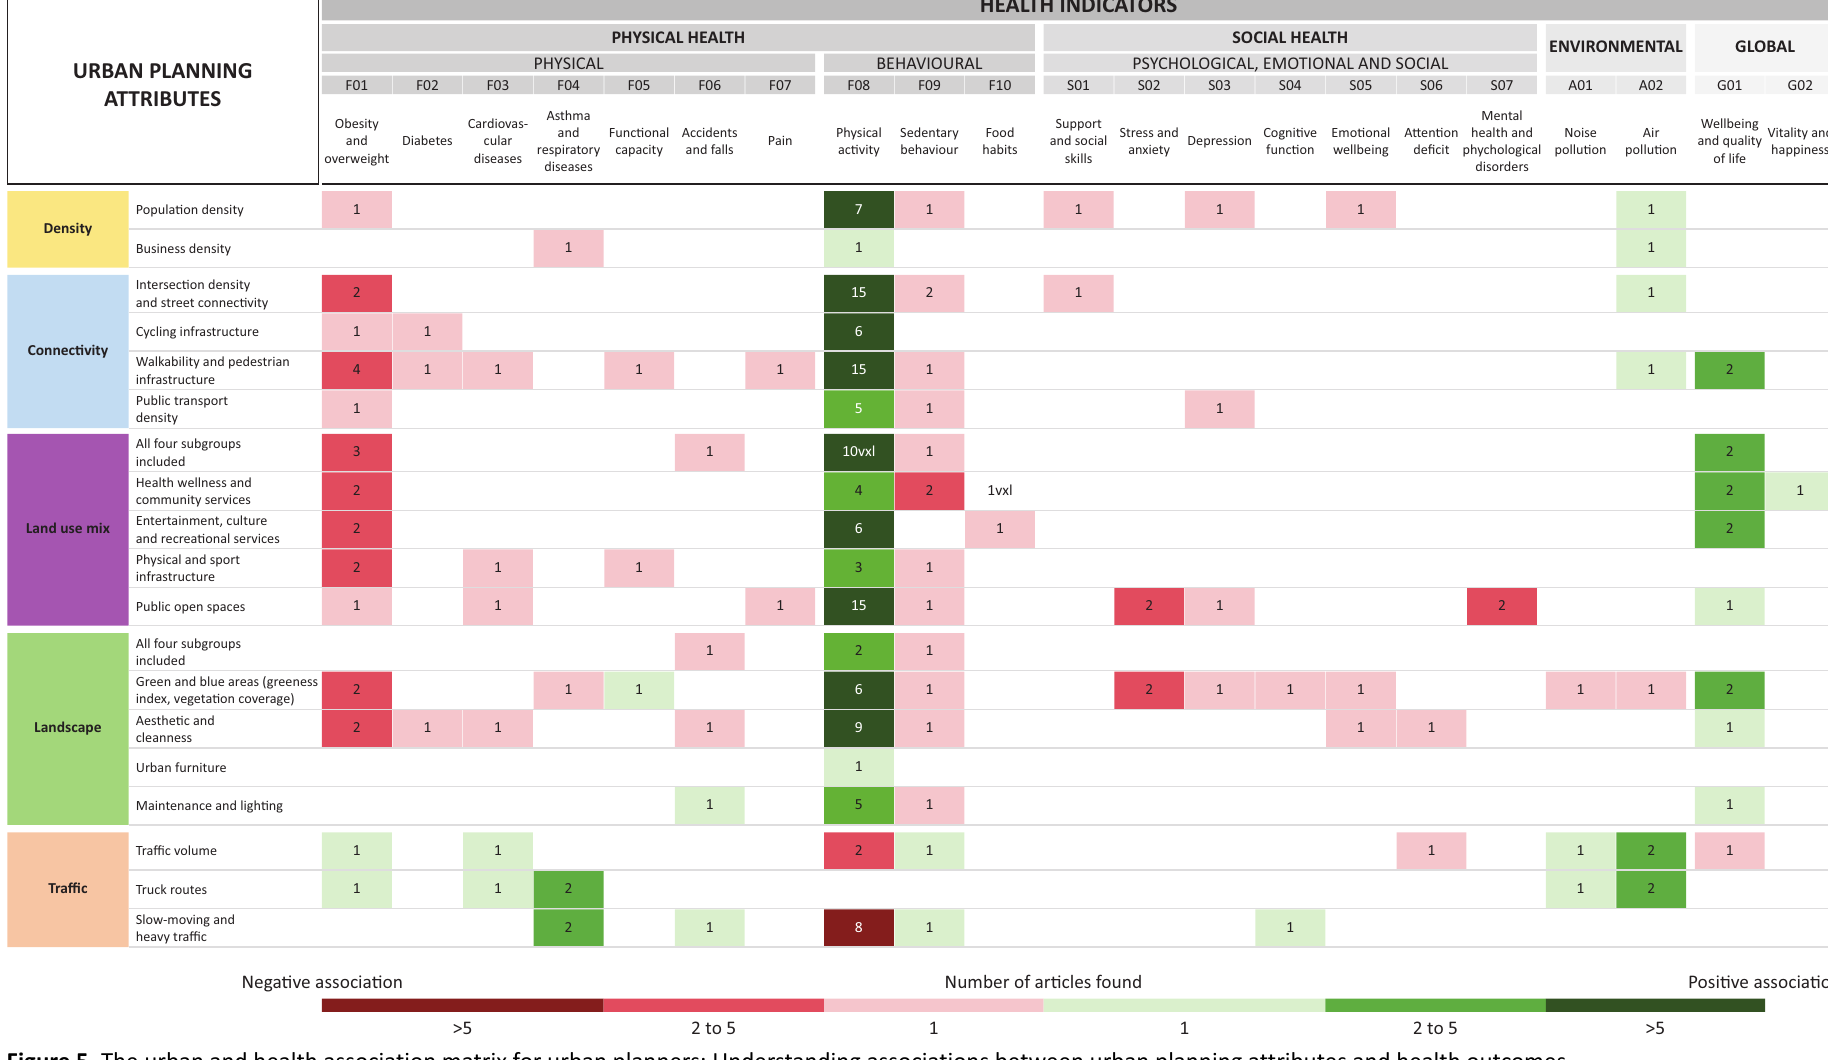
Urban Planning, 2022, Volume 7, Issue 4, Pages